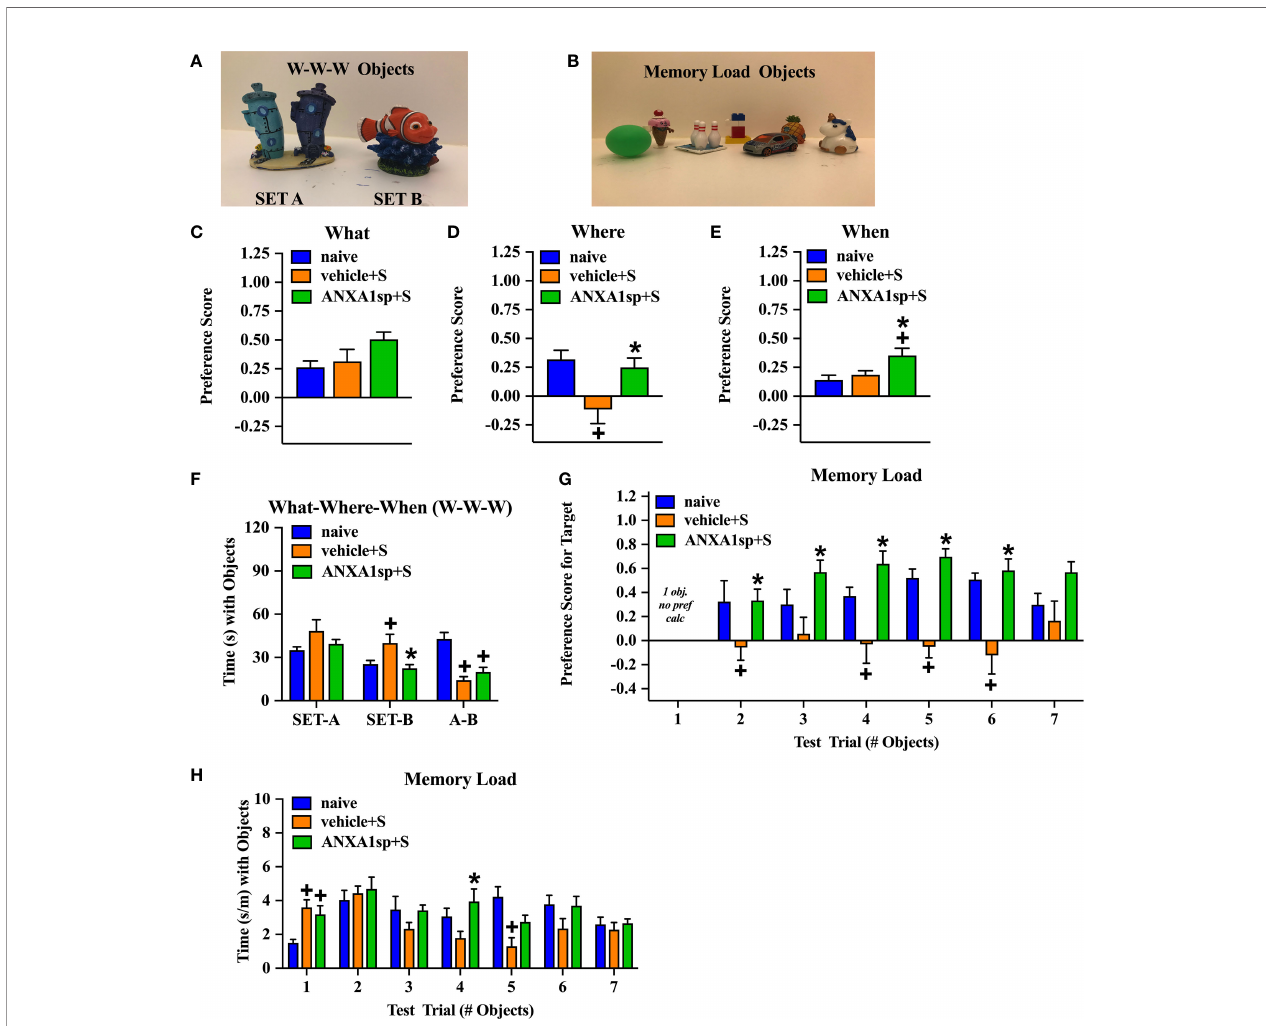
FIGURE 5 | PND-like cognitive responses in adult mice treated prior to surgery with the vehicle or ANXA1sp. Example of Set A and Set B objects used in the “ What-Where- When ” memory task (A) . Example of the seven unique objects used in the Memory Load task (B) . Preference scores for “ What ” object recognition memory in the “ What- Where-When ” task (C) . Preference scores for “ Where ” recognition memory for the displaced object in the “ What-Where-When ” task (D) . Preference scores for “ When ” recognition memory for recent objects to previously investigated objects in the “ What-Where-When ” task (E) . The time (s) spent exploring Set A and Set B objects, and at testing in the “ What-Where-When ” task (F) . Preference scores for the novel object in the Memory Load test (G) . Mean time (adjusted by trial length) that animals explored objects in the seven consecutive trials in the Memory Load test (H) . N = 10 mice/treatment group for all tests. * P < 0.05, compared to vehicle + surgery mice; + P < 0.05, compared to naïve animals. Results are shown as mean ± SEM and analyzed by MANOVA. Representative data are from one